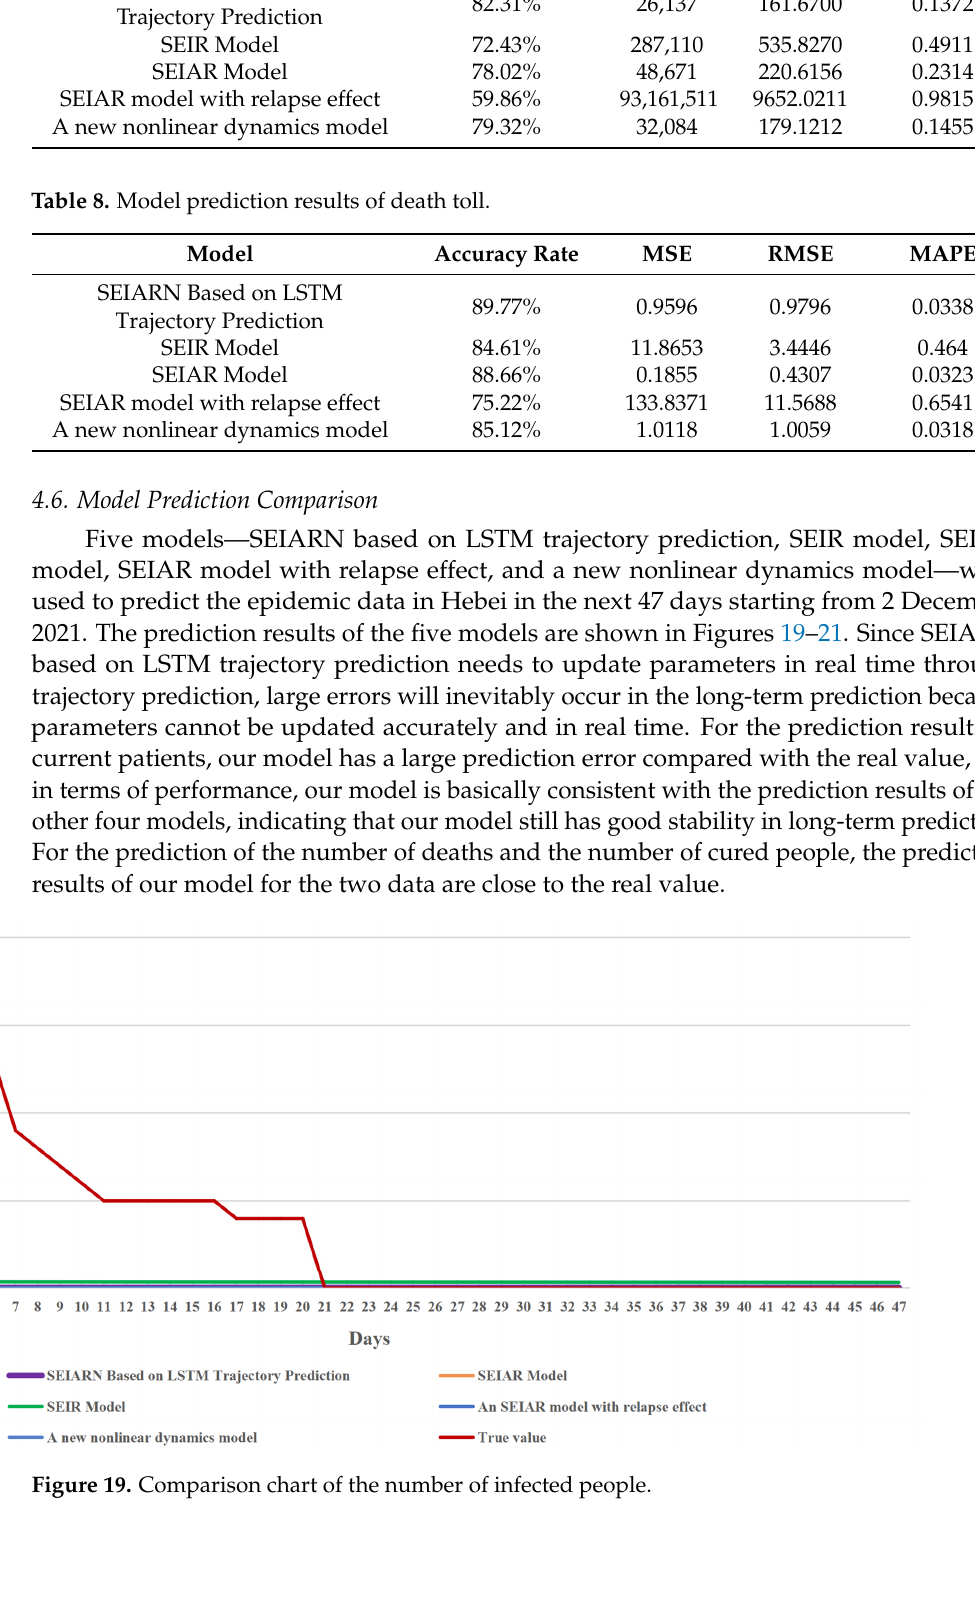
Figure 20. Comparison chart of the number of deaths.